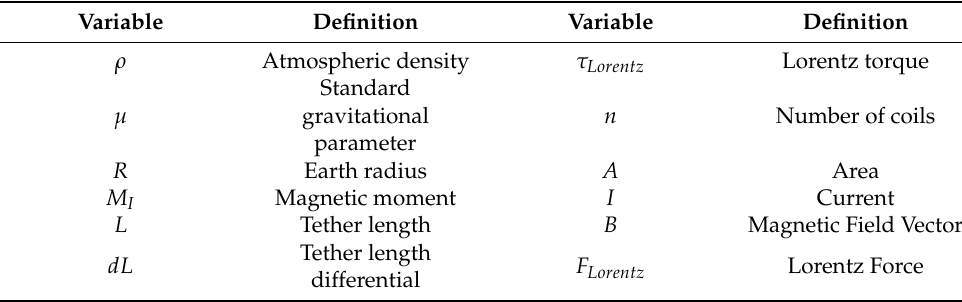
Table 4. Definitions of variables proximal to Table